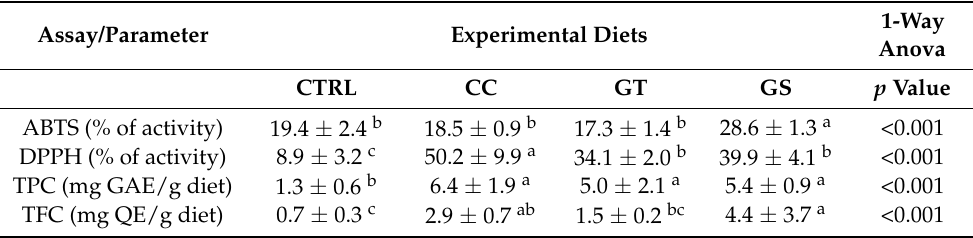
Table 1. Antioxidant properties (expressed as % of activity) and total phenolics (TPC; expressed as mg GAE/g diet) and flavonoids contents (TFC; mg QE/g diet) of methanol extracts from the experimental diets (CTRL, CC, GT, and GS).